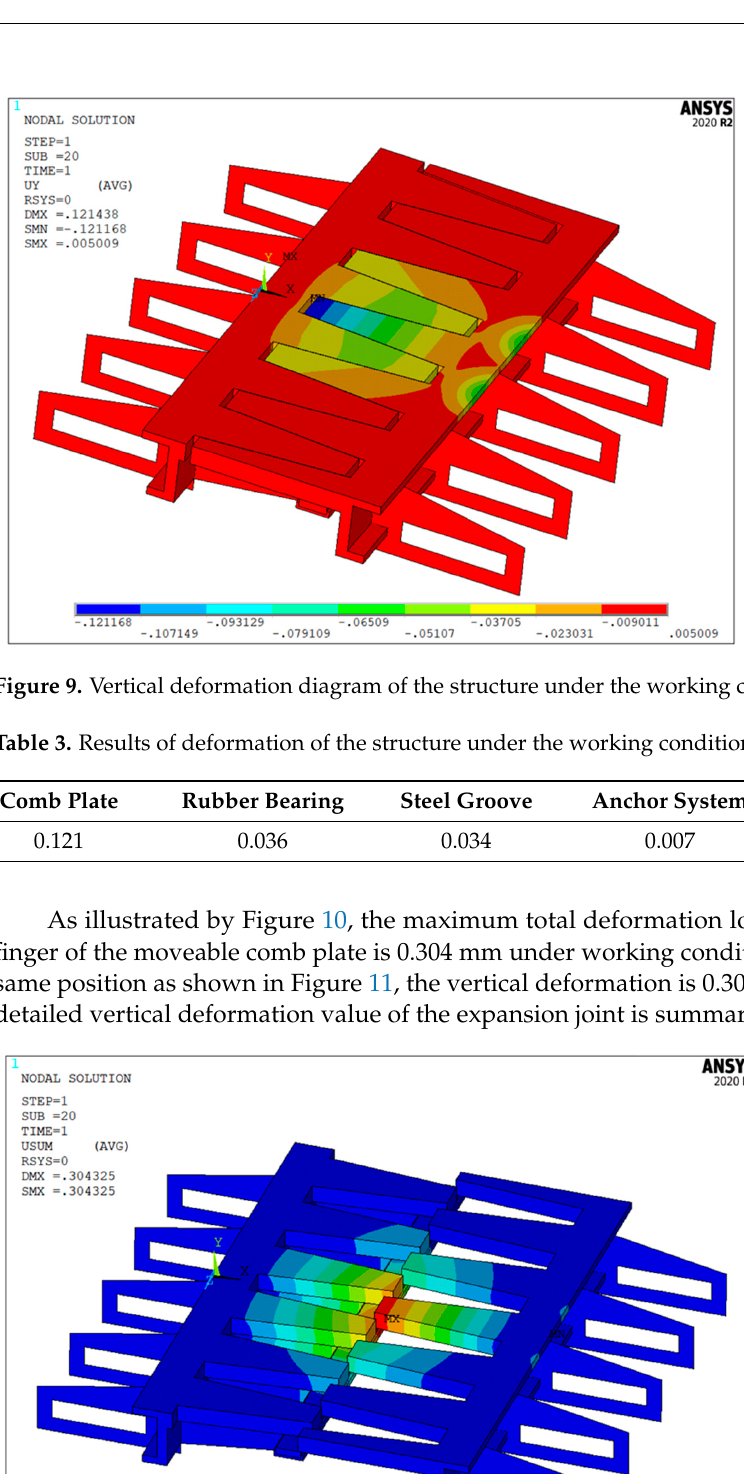
Figure 10. Maximum total deformation diagram of the structure under the working condition II.